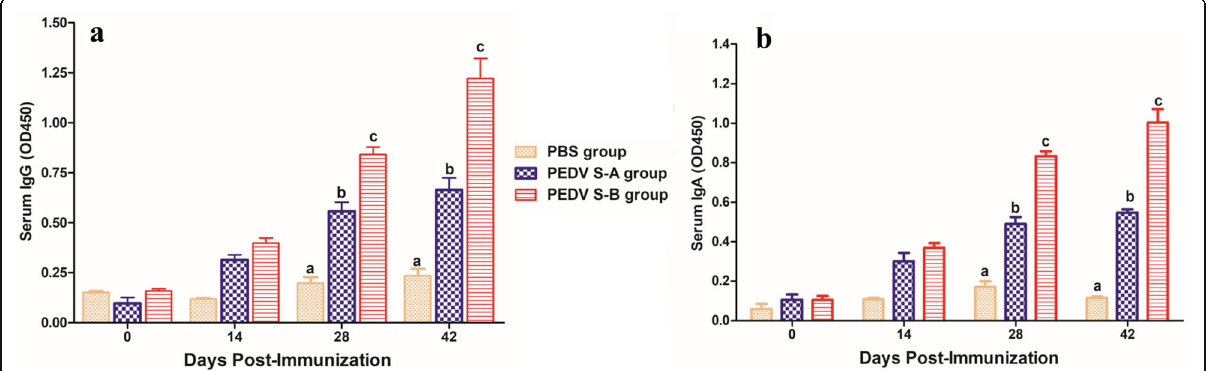
Fig. 2 PEDV-specific IgG and IgA in the sera of the immunized mice by indirect ELISA. a PEDV-specific IgG detected by indirect ELISA. b PEDV- specific IgA detected by indirect ELISA. Data were represented as the mean ± SEM. Different letters ( a , b ) indicate a statistically significant difference between the different experimental groups ( P < 0.05). PEDV, porcine epidemic diarrhea